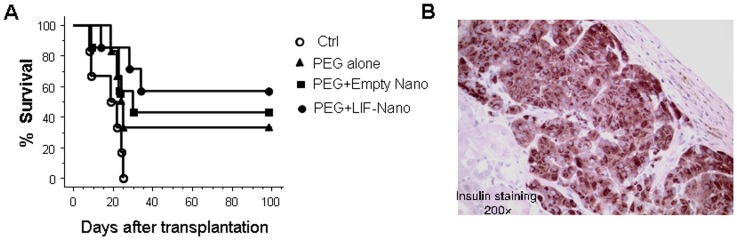
Prolonged functionality of encapsulated islets in vivo.Pancreatic islets from DBA/2 mice were grafted under the kidney capsule of C57BL/6 recipients: the islets were either untreated (Ctrl); or encapsulated in PEG alone (PEG alone); or with PEG decorated with empty nanoparticles (PEG+Empty Nano); or with PEG decorated with LIF-containing nanoparticles (PEG+LIF-Nano). The ability of these grafts to support normoglycemia over 100 d is shown as “% survival” in (A). Histology of grafts taken from recipients showing normoglycemia at 100 d revealed well-preserved β cells containing insulin, as illustrated in (B).